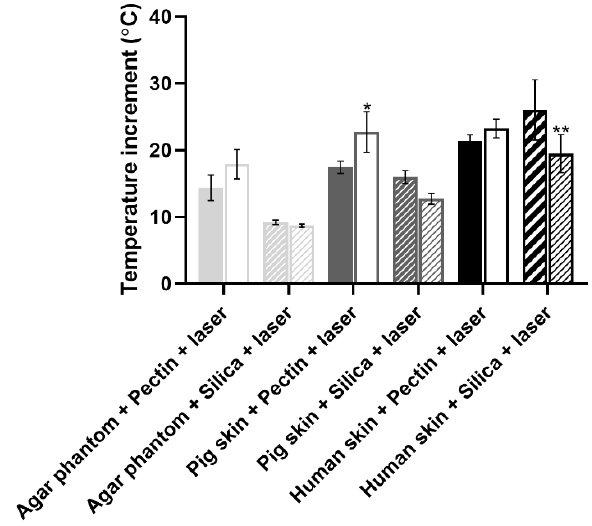
Figure 8. Temperature increment observed for agar phantoms and pig and human skin ex vivo grafts after 15 min of NIR laser exposure. For each test group, full columns (left column) refer to directly irradiated areas, whereas empty and stripped columns (right) refer to areas under aerogel structures being irradiated. Statistical significance represents * p < 0.05 and ** p < 0.01 compared with directly irradiated areas from the same group.